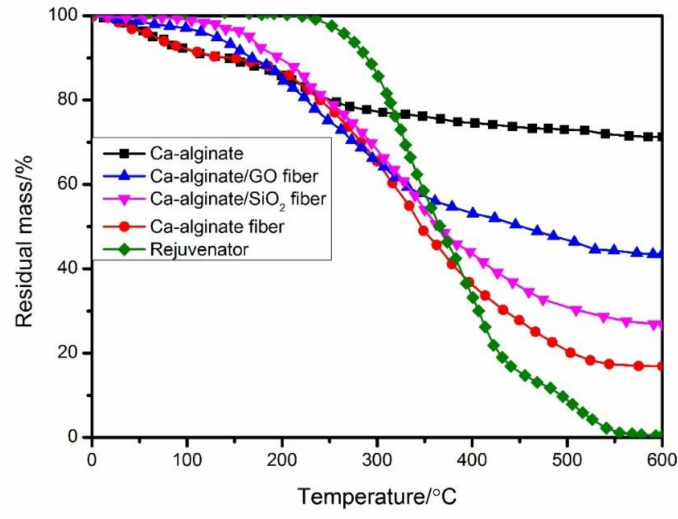
Figure 4. Thermal stability of the three kinds of